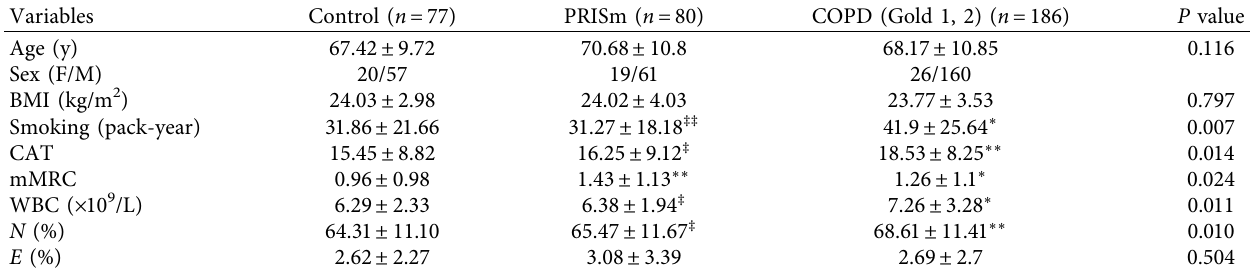
Table 1: Baseline characteristics of patients in this study (Mean ± SD).